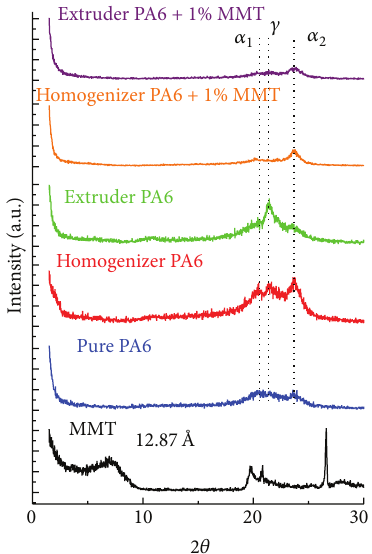
Figure 1: X-ray diffraction curves of clay, pure polyamide, and